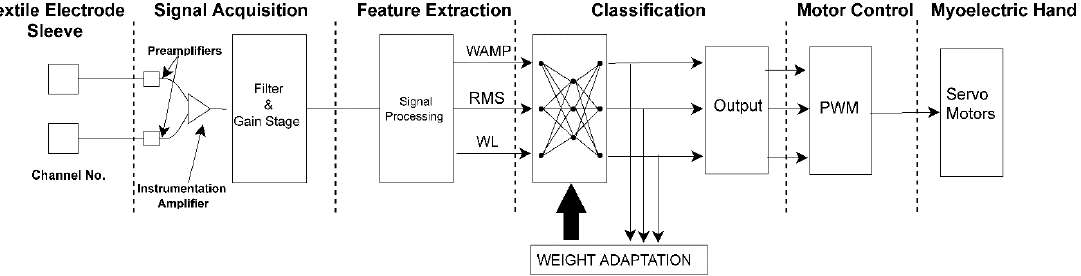
Figure 5. Flowchart of the system used for the EMG-based control of the myoelectric prosthetic hand shown for one of the seven channels.